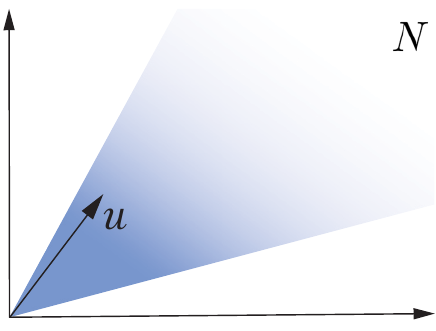
Figure 4 . A conical neighborhood N of a vector u in a 2-dimensional vector